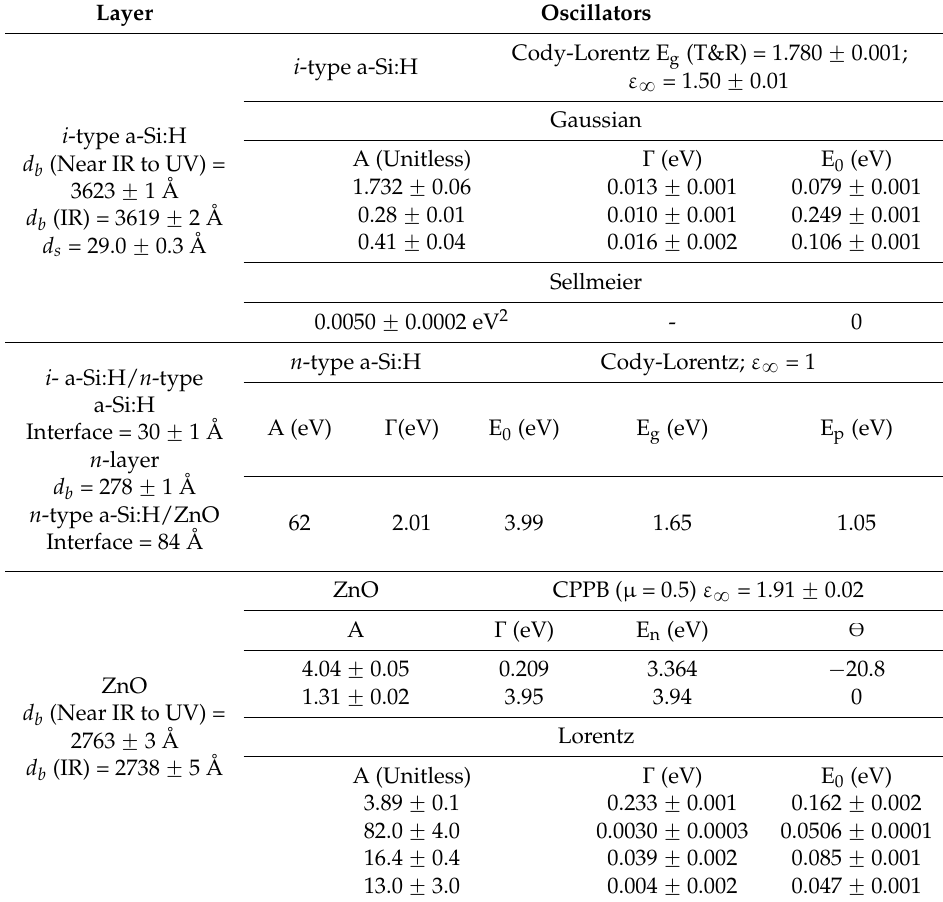
Table 5. Parameters describing ε and structure for a ZnO/Ag BR coated with n -type and intrinsic a-Si:H. Experimental ellipsometric spectra were collected ex situ using near infrared to ultraviolet (0.734 to 5.0 eV) and infrared (0.04 to 0.734 eV) spectral range instruments and fit jointly using least squares regression analysis with an unweighted estimator error function, σ = 11 ˆ 10 ´ 3 . Parameters describing ε for Ag and the ZnO + Ag interface were fixed from Tables 2 and 3 respectively. Parameters describing ε for the n -layer were determined from RTSE analysis of data collected at T = 200 ˝ C, parameterized by a Cody-Lorentz oscillator, and then parameter values extrapolated to room temperature. The ZnO and intrinsic a-Si:H bulk layer thicknesses were allowed to vary separately for each set of spectra; all other parameters are common to both analyses. For ZnO, the parameterization of ε consisted of two CPPB oscillators with all parameters except the amplitudes fixed to the values in Table 4, four Lorentz oscillators, and ε 8 . For a-Si:H layers, the parameterization of ε was based on a Cody-Lorentz oscillator and ε 8 . A Sellmeier oscillator and three Gaussian oscillators were added to the parameterization of ε for intrinsic a-Si:H.